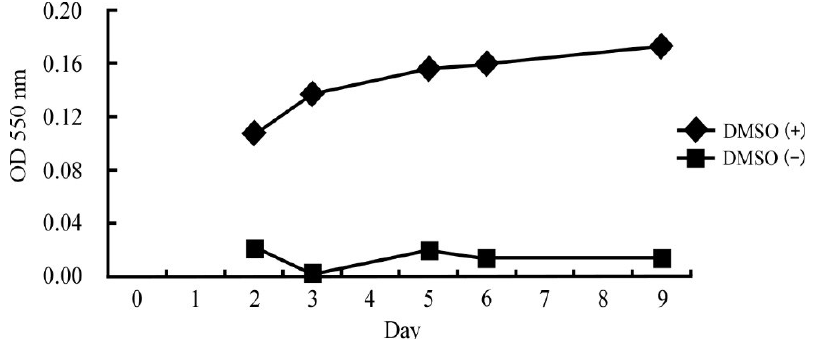
Figure 1. OD value at 550 nm, used to estimate the amount of superoxide in untreated and DMSO-treated HL-60